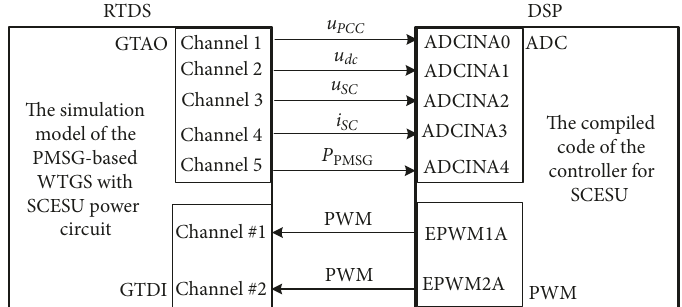
Figure 7: Connection diagram of RTDS and DSP.